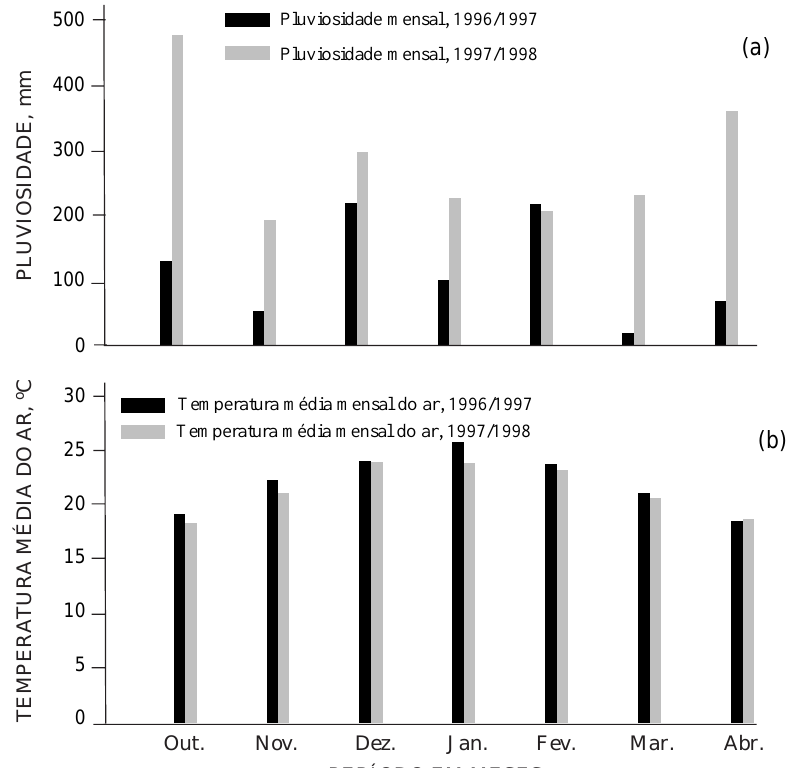
Figura 1. Pluviosidade mensal (a) e temperatura média mensal do ar (b) nos períodos agrícolas de 1996/ 97 e